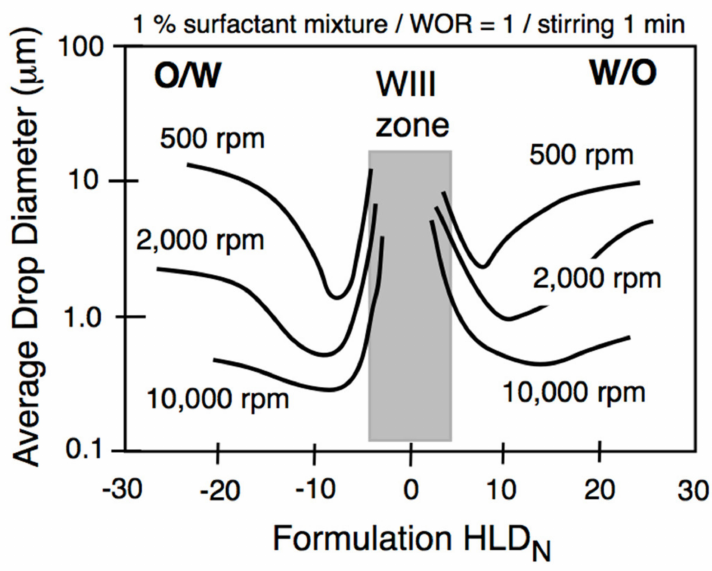
Figure 14. Emulsion drop size variation along a formulation scan at variable stirring energy indicated as revolutions per minute rpm (unpublished data similar to reported trends). Adapted from